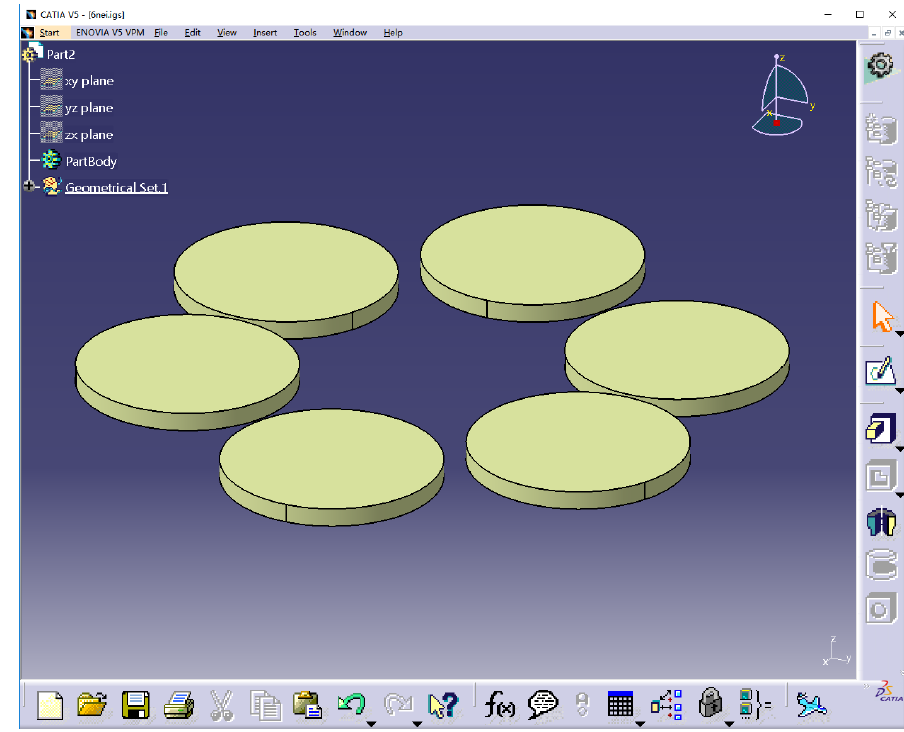
Figure 4. Physical model of moving fields.